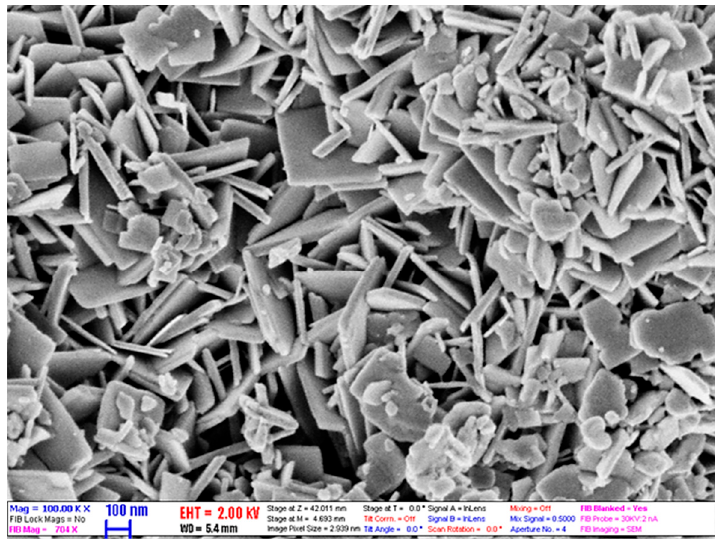
Figure 1. Scanning electronic microscope SEM image of tungsten oxide nanoflakes.